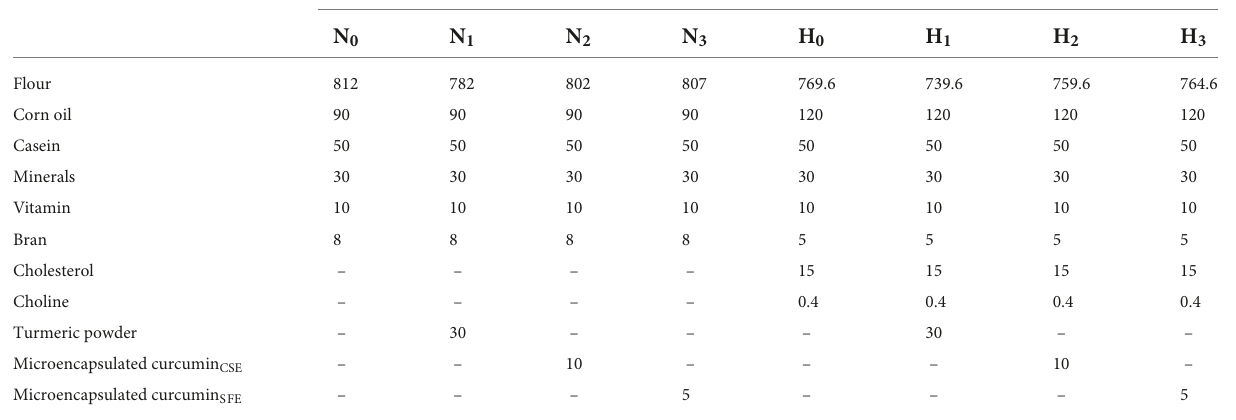
TABLE 2 Diet composition for different rat